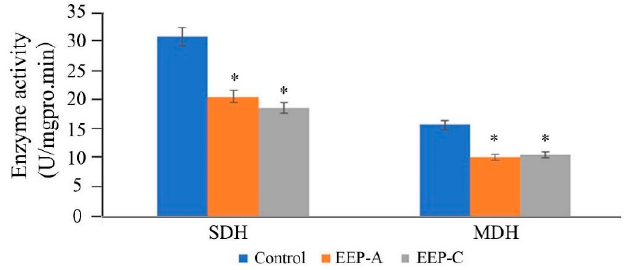
Figure 5. Effect of propolis on succinate dehydrogenase (SDH) and malate dehydrogenase (MDH) activities of P. notatum (n = 3, * p < 0.05).